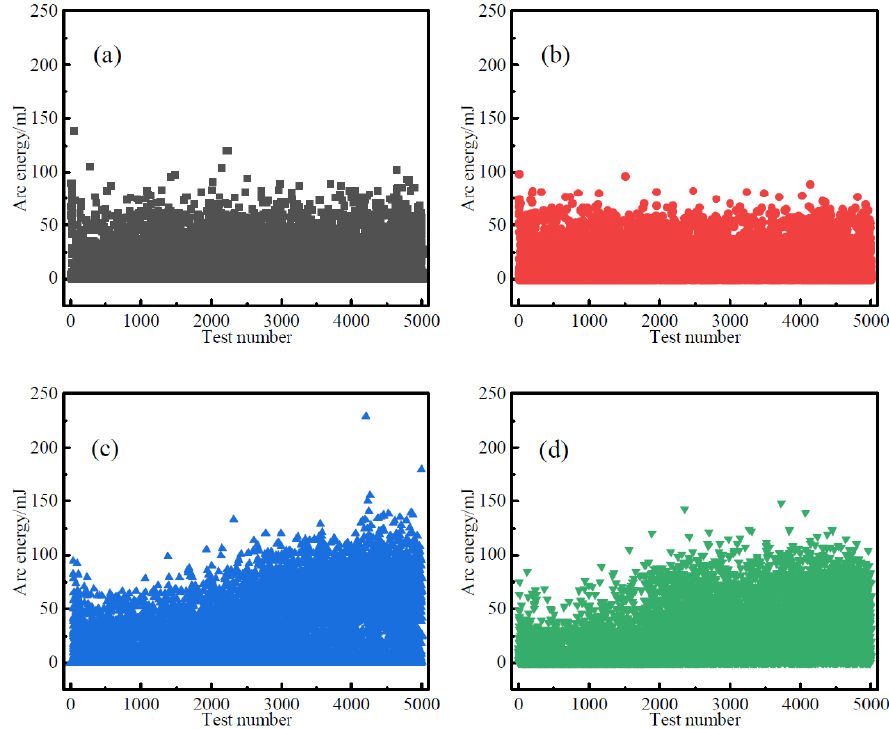
Figure 9. Variation in arc energy of Cu-W composite contacts with different W contents: ( a ) Cu; ( b ) Cu-10 wt% W; ( c ) Cu-20 wt% W; ( d ) Cu-30 wt% W.